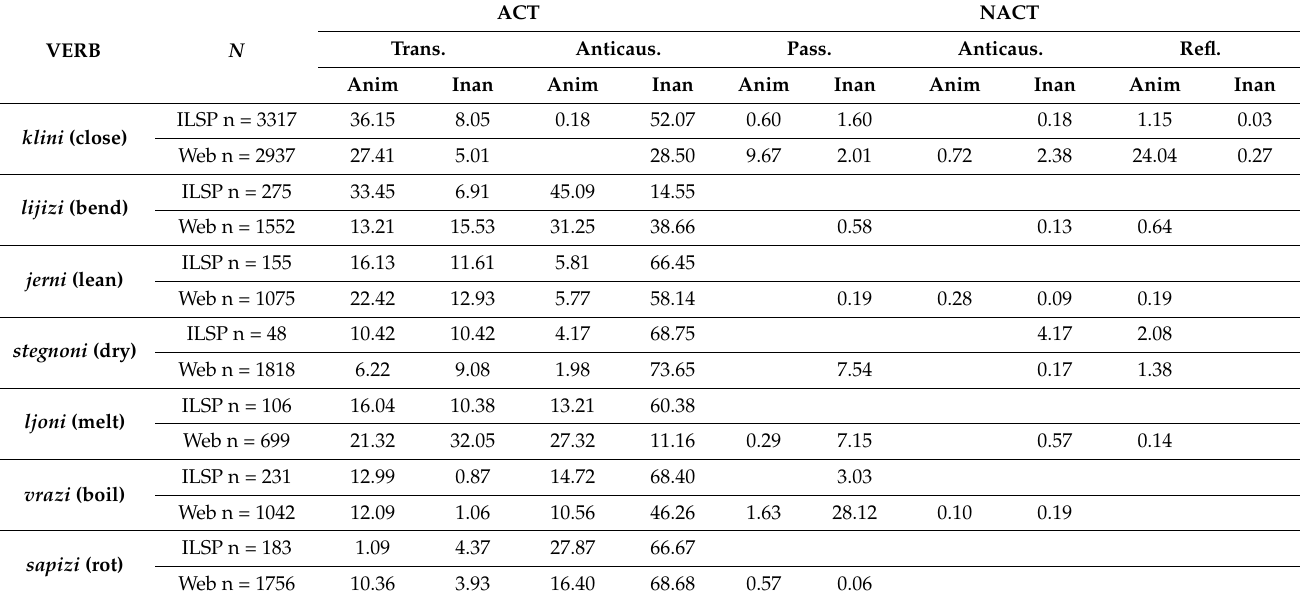
Table 1. Distribution of readings (%) among ‘voice non-alternating’ anticausatives by voice morphol- ogy and [+/ − animacy] of the syntactic